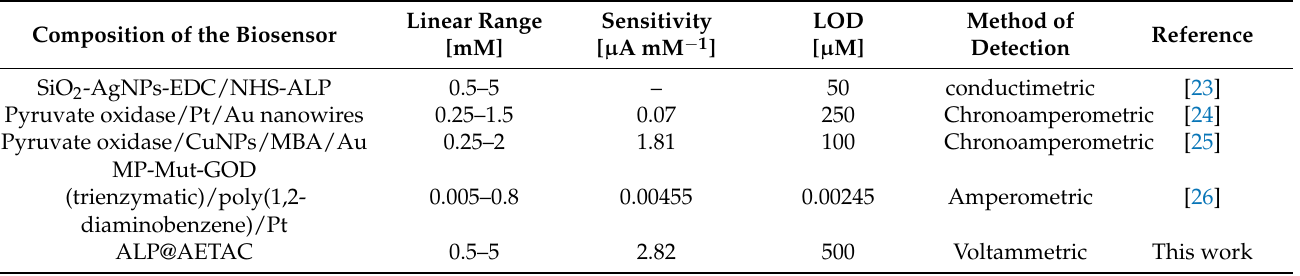
Table 1. Comparison of the figures of merit for the ALP@AETAC-modified electrode in the detection of phosphates with other biosensors reported in the